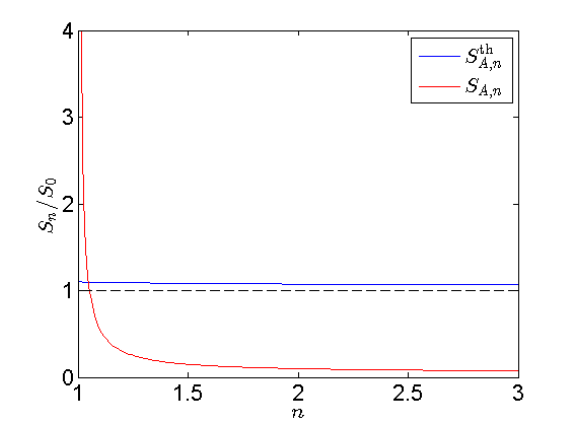
Figure 7 . Comparison of the R(cid:19)enyi entropy S A;n that we obtained in eq. (5.22) and the thermal R(cid:19)enyi entropy. The entropies are measured by the zero temperature entropy, and the curves are plotted for c v T = 0 : S 0